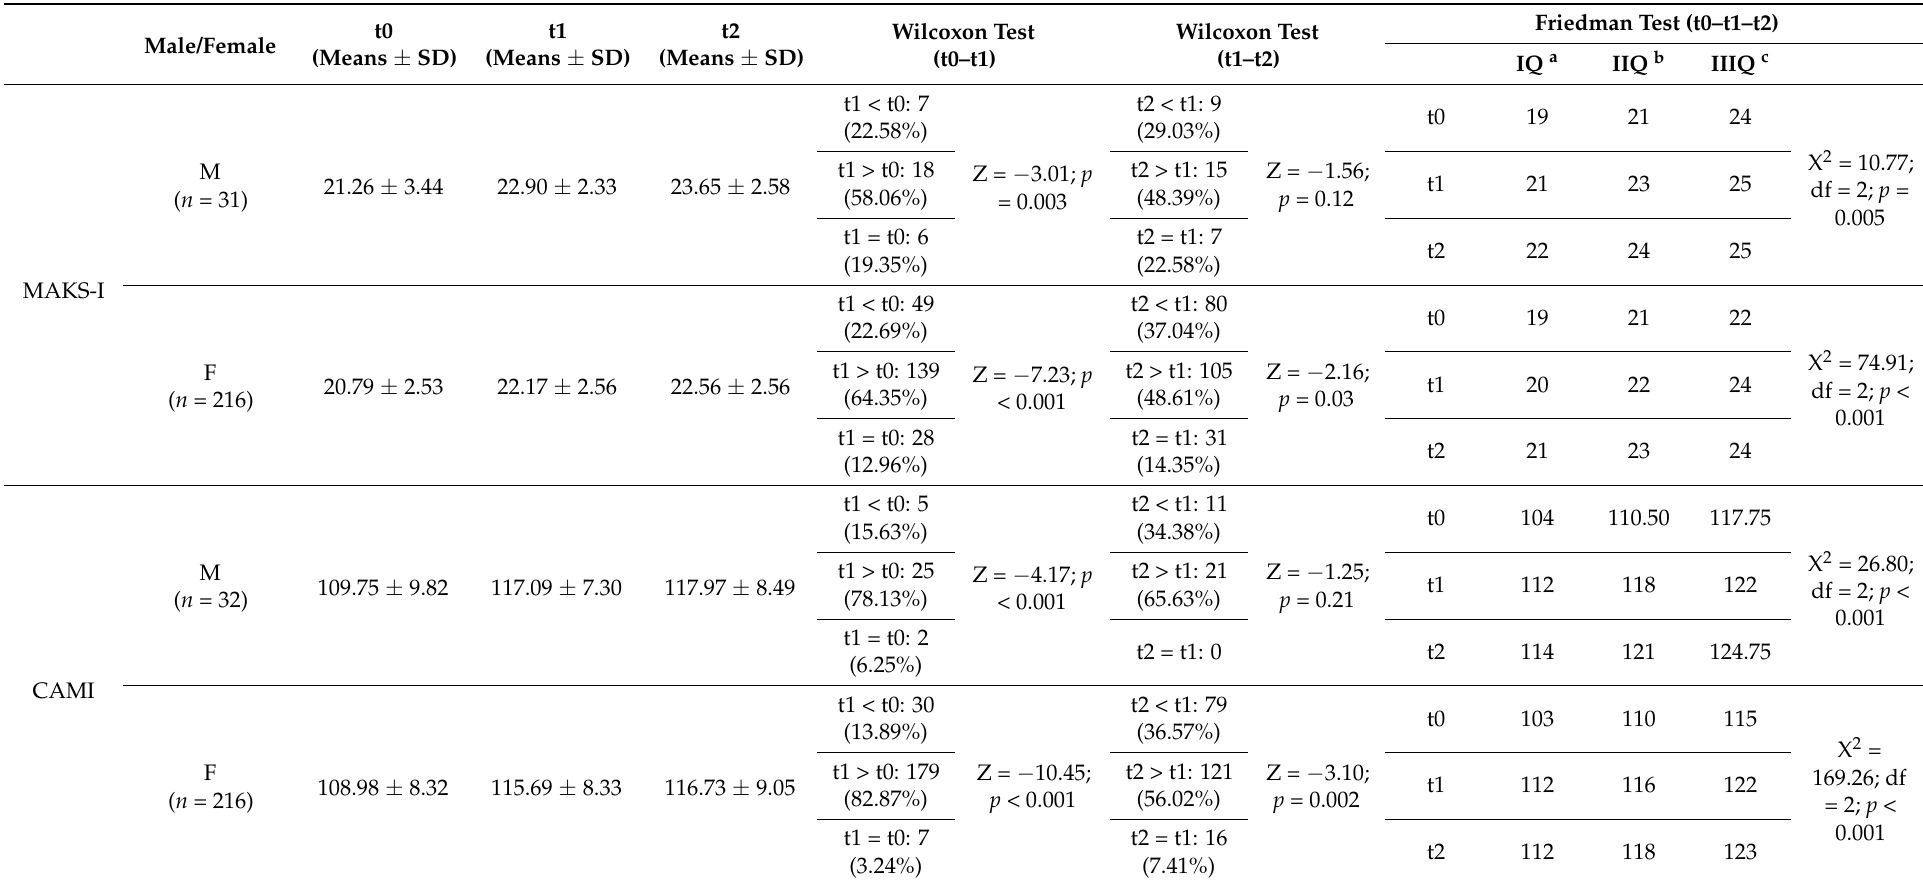
Table 3. Trend over time of the scores obtained in the knowledge of mental disorders (MAKS-I), the attitudes towards people who are mentally ill (CAMI), and the intended behaviour towards people with mental illness (RIBS-I) for male and female